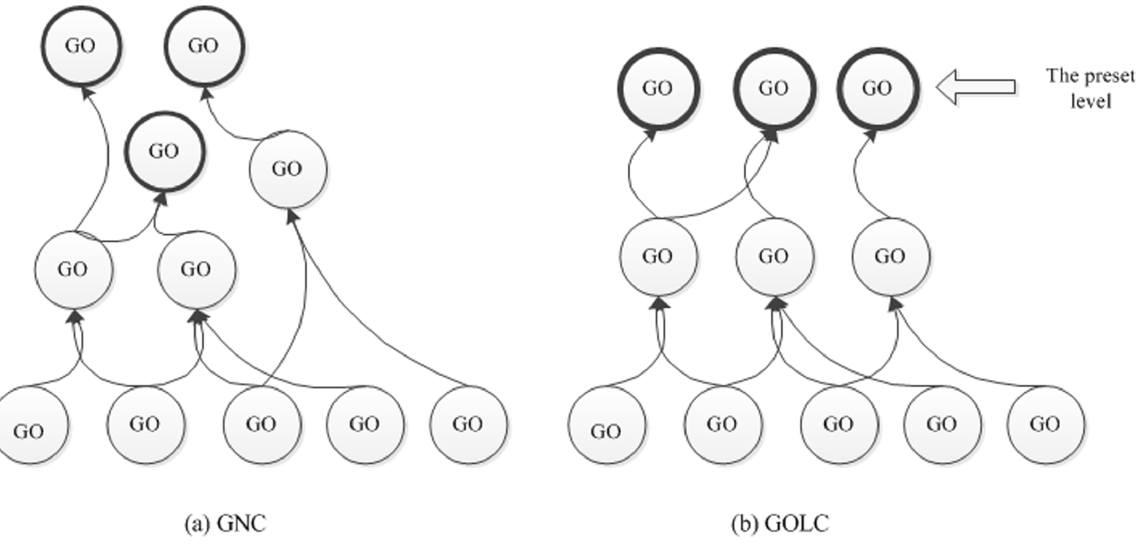
Figure 2. GO in the last level up-propagate along GO DAG. (a) The bold GO terms all own at least l genes. (b) The bold GO terms are in the ‘ level of GO